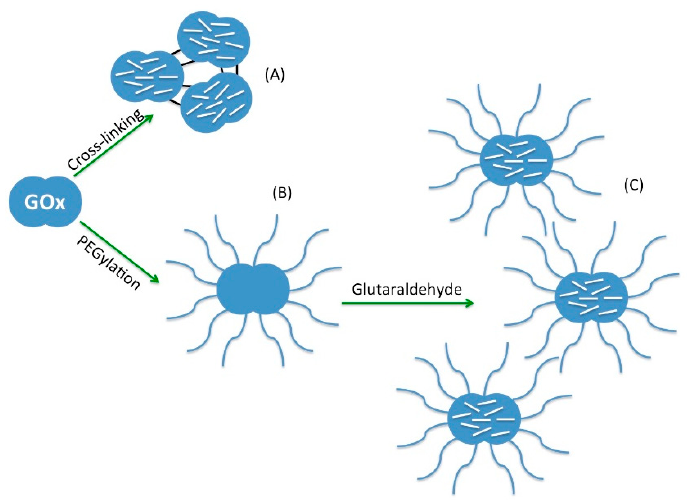
Figure 4. PEGylation of GOx ( B ) followed by chemical modification ( C ) enhances enzyme stability, while preventing intermolecular crosslinking contrary to direct cross-linking ( A ). Reprinted with authorization from [76].